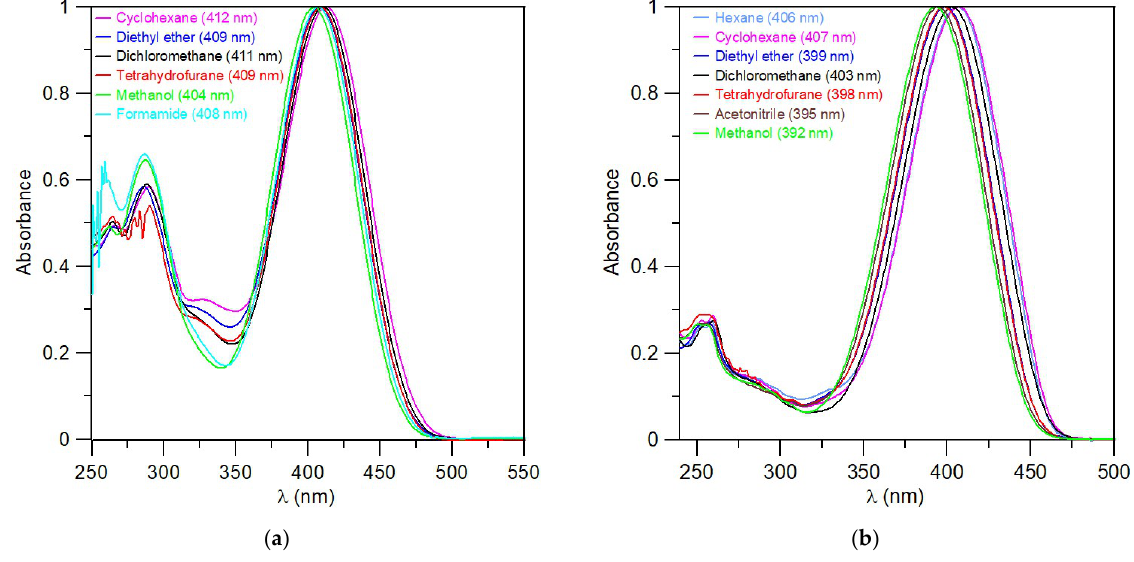
Figure 6. Normalized UV–Vis spectra of triazaborinone 5g ( a ); and diazaborinone 7a ( b ).